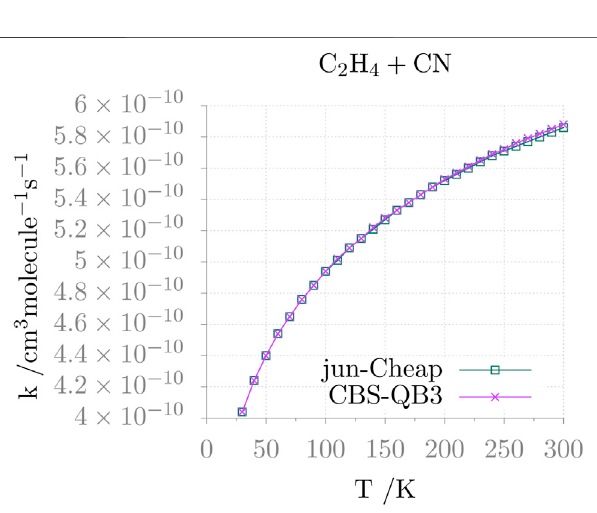
FIGURE 4 | Rate constant as a function of the temperature ( k ( T )) for the C 2 H 4 + CN addition